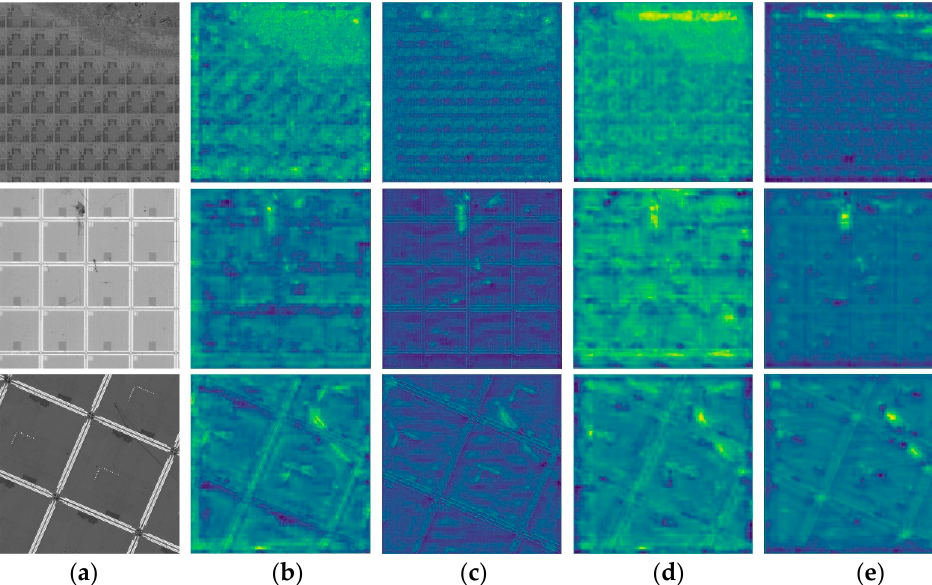
Figure 7. Visualization of feature maps: ( a ) input image, ( b ) P2 feature map, ( c ) P2 FEM feature map, ( d ) P3 feature map, and ( e ) P3 FEM feature map.